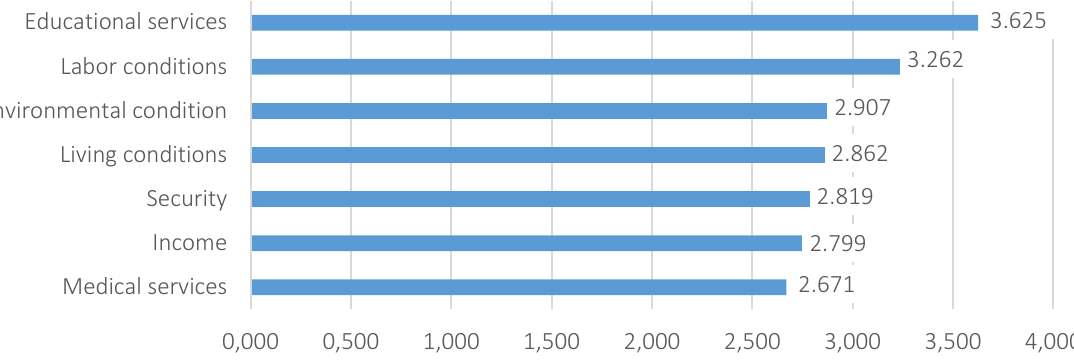
Figure 3. Deprivation levels of individual components, Lviv Oblast, Ukraine,